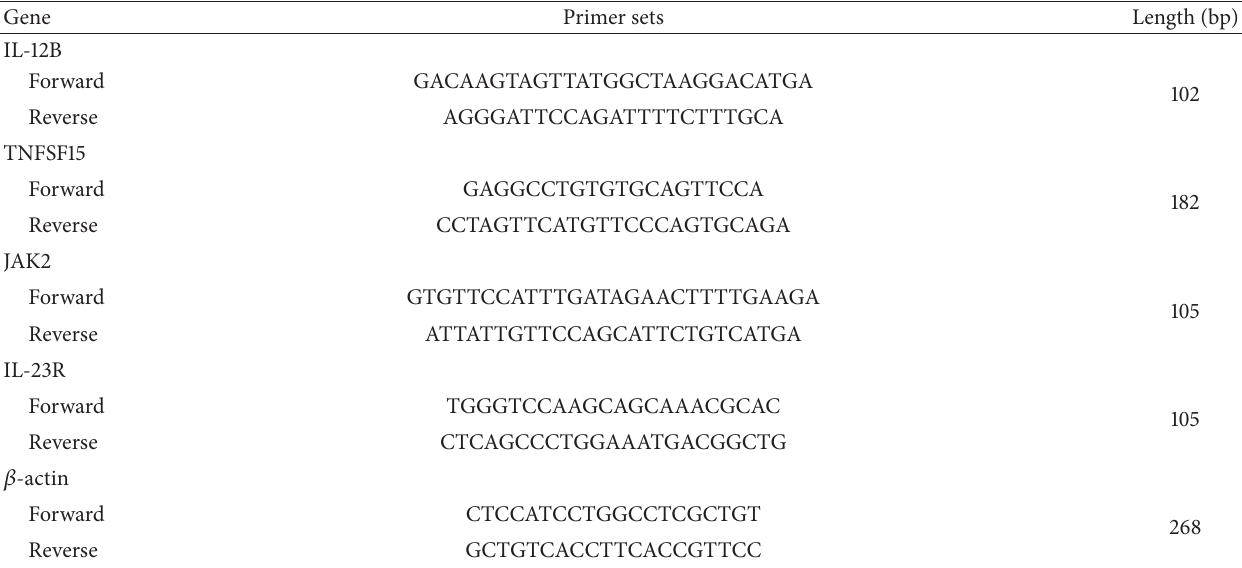
Table 2: Primer sets used for quantitative real-time